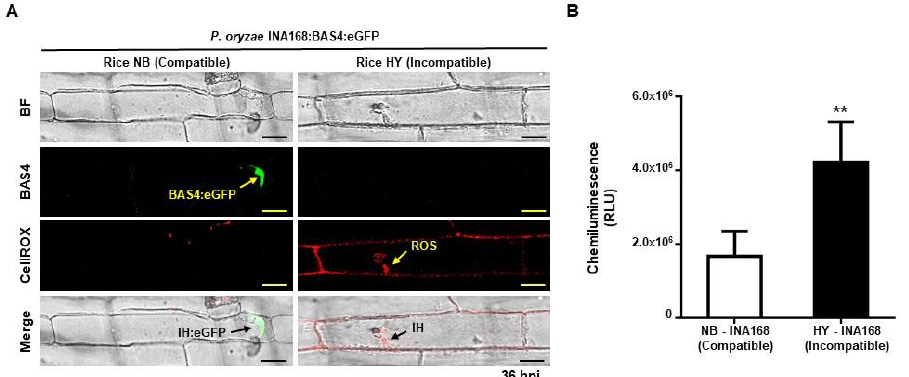
Figure 3. ROS accumulation inhibited the expression of BAS4 effector in P. oryzae INA168:BAS4:eGFP invasive hyphae in the incompatible interaction with rice cv. HY. ( A ) BAS4 expression and ROS accumulation in leaf sheaths of rice cv. NB and HY during P. oryzae INA168:BAS4:eGFP infection. CellROX staining was performed to detect ROS accumulation. Arrow indicates ROS accumulation and BAS4 secretion. All images were captured using confocal laser microscopy with bright field, green fluorescence filter (488 nm excitation/505 – 550 nm emission), or red fluorescence filter (644 nm excitation/665 nm emission). Scale bars = 10 µm. ( B ) Quantification of ROS in leaf sheaths of rice